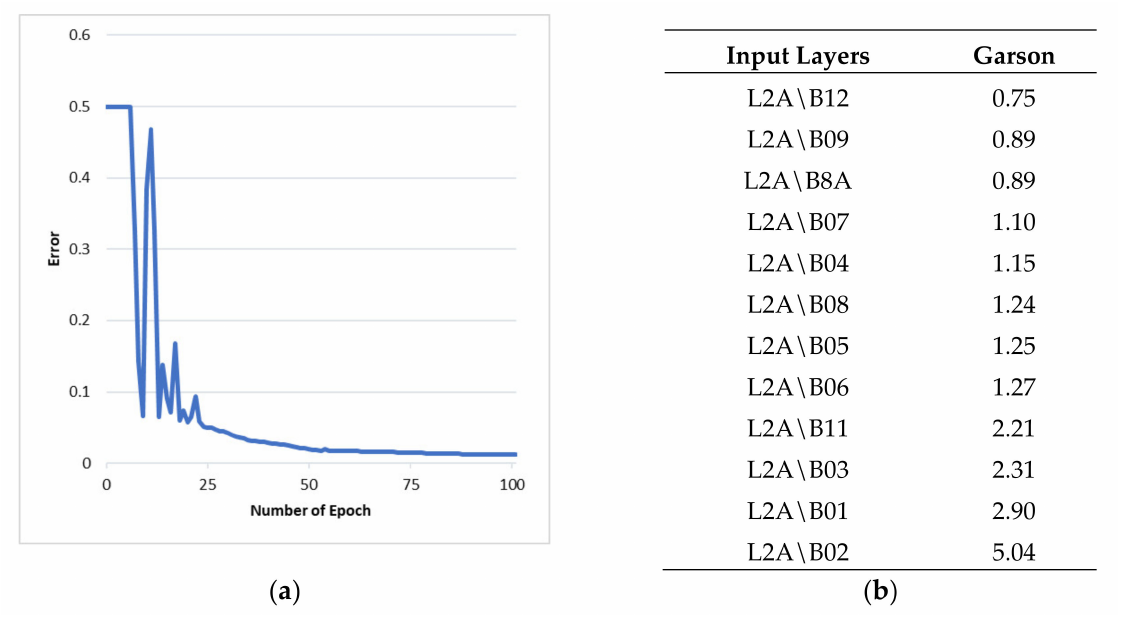
Figure 23. ( a ) Plot of MSE and ( b ) weight parameters for the MLP based on Sentinel-2 Level-2A BOA products.